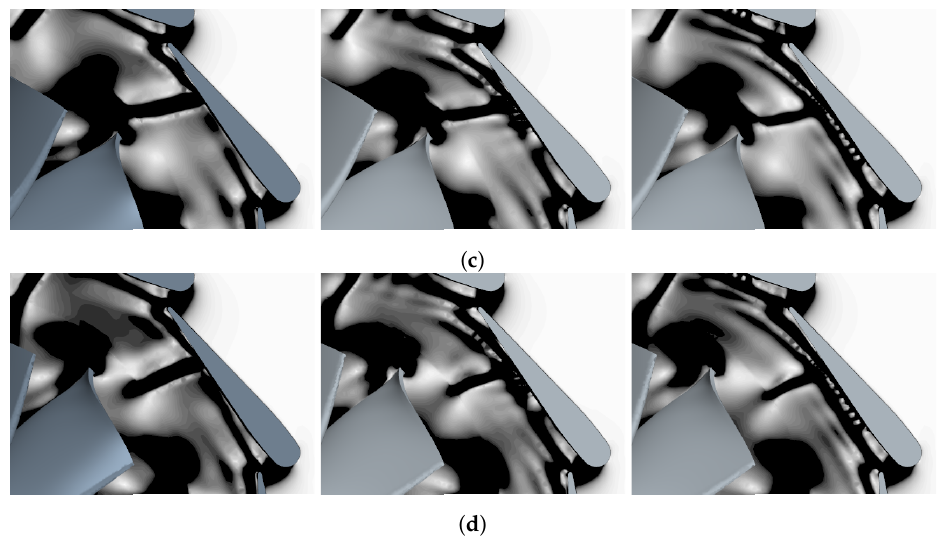
Figure 12. Transient numerical schlieren for 10% VGT opening at 50% span of the stator passage with higher simulated PR and lower speed; left side: Original geometry; middle: Geometry with 5 grooves in the stator; right side: Geometry with 11 grooves in the stator. ( a ) t = 25% rotor blade passing. ( b ) t = 50% rotor blade passing. ( c ) t = 75% rotor blade passing. ( d ) t = 100% rotor blade passing.